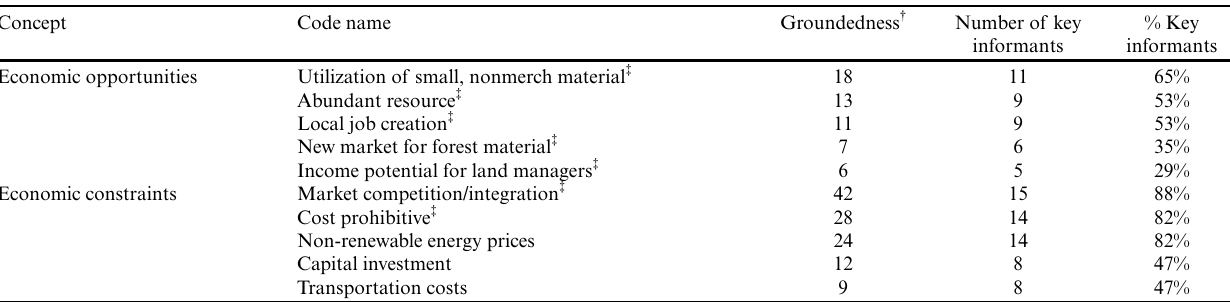
Table 2 . Economic opportunities and constraints of wood-based bioenergy (WBB) in western Montana. For each root code and subcode, we include the number of times the code was referred to in the interviews (groundedness), the number of key informants that discussed the code, and the percentage of key informants that described the